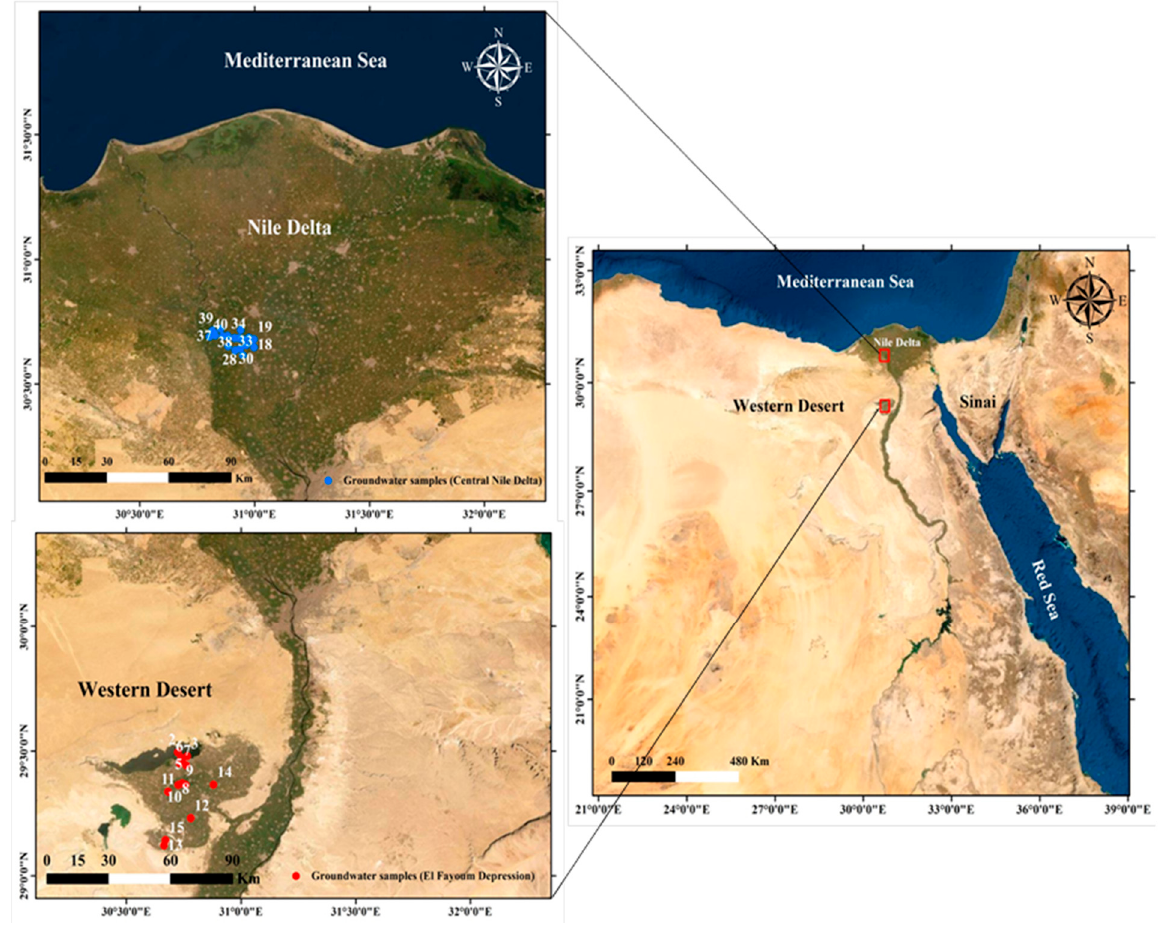
Figure 1. Location map of the El Fayoum depression in the Western Desert (red points) and the Central Nile Delta (blue points) and their sampling points. Table 1. Formula and references for different irrigation water quality indices applied in this study.